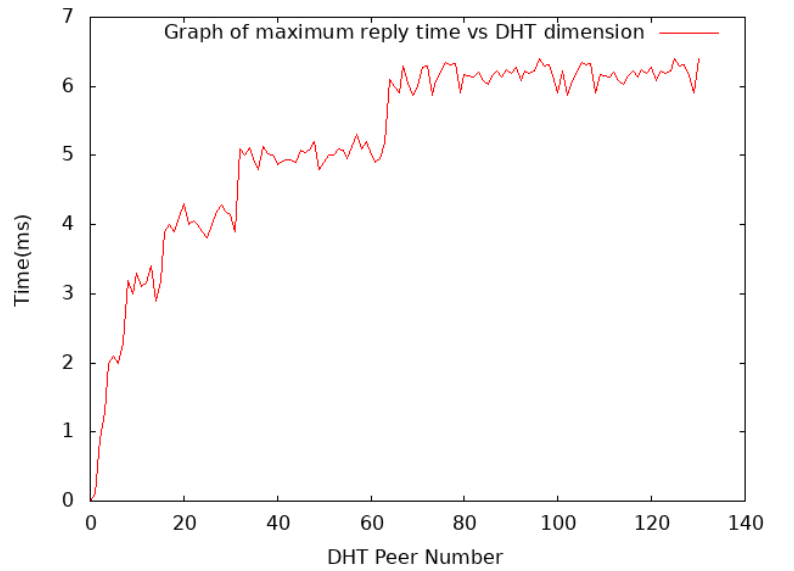
Figure 5. The extra time needed by the system to reply to the client, via the